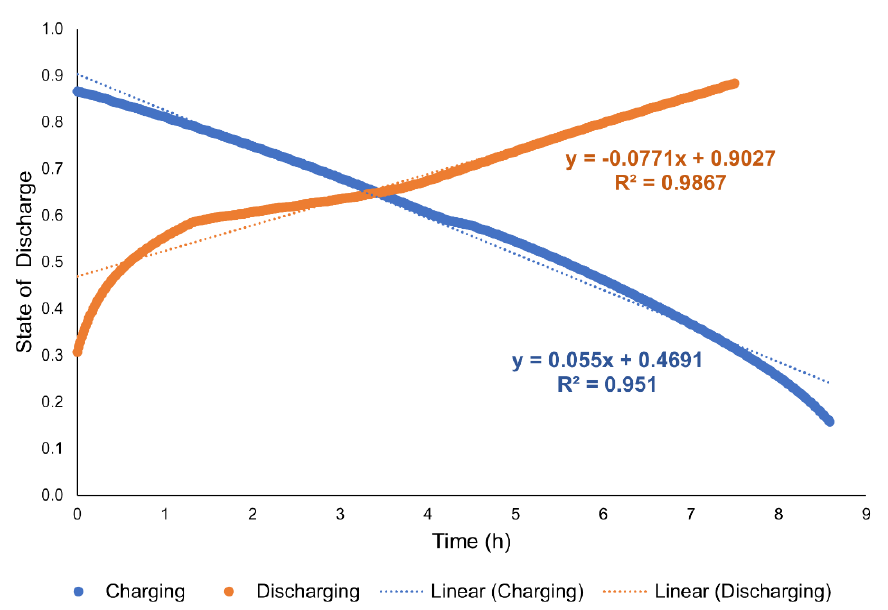
Figure 5. Plot of state of discharge vs. time for a single NaS cell.